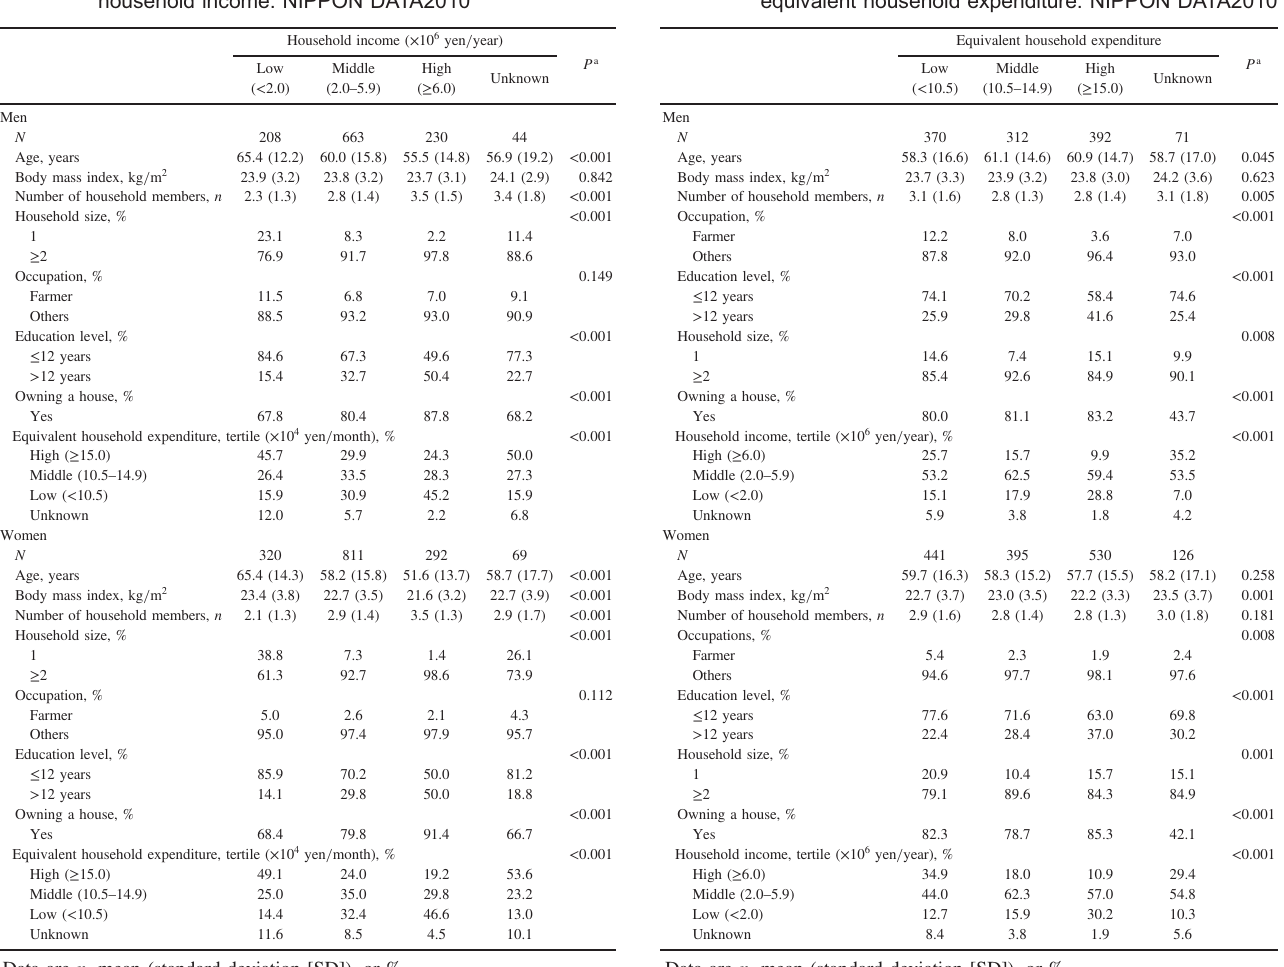
Table 1. Characteristics of study participants according to the household income: NIPPON DATA2010